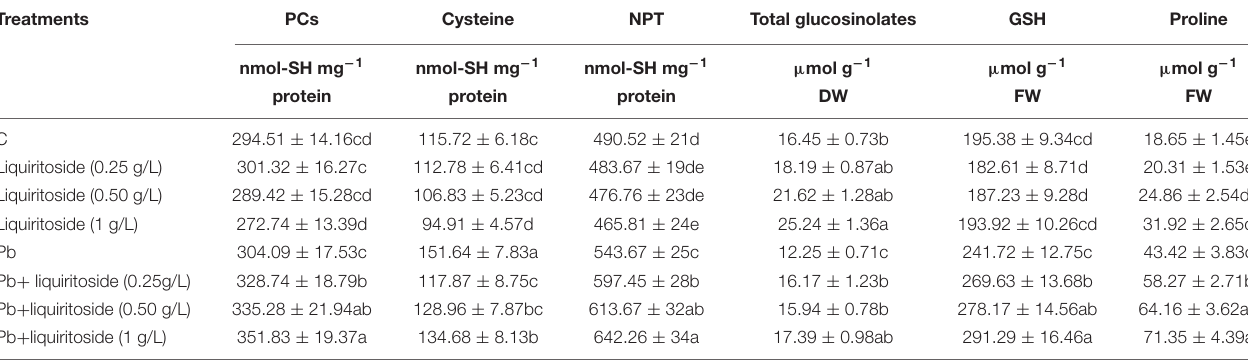
TABLE 3 | Effect of liquiritoside on the levels of phytochelatins (PCs), cysteine, non-protein thiols (NPT), glucosinolates, glutathione (GSH) and proline in Chinese flowering cabbage plants under lead (Pb) stress. Treatments PCs